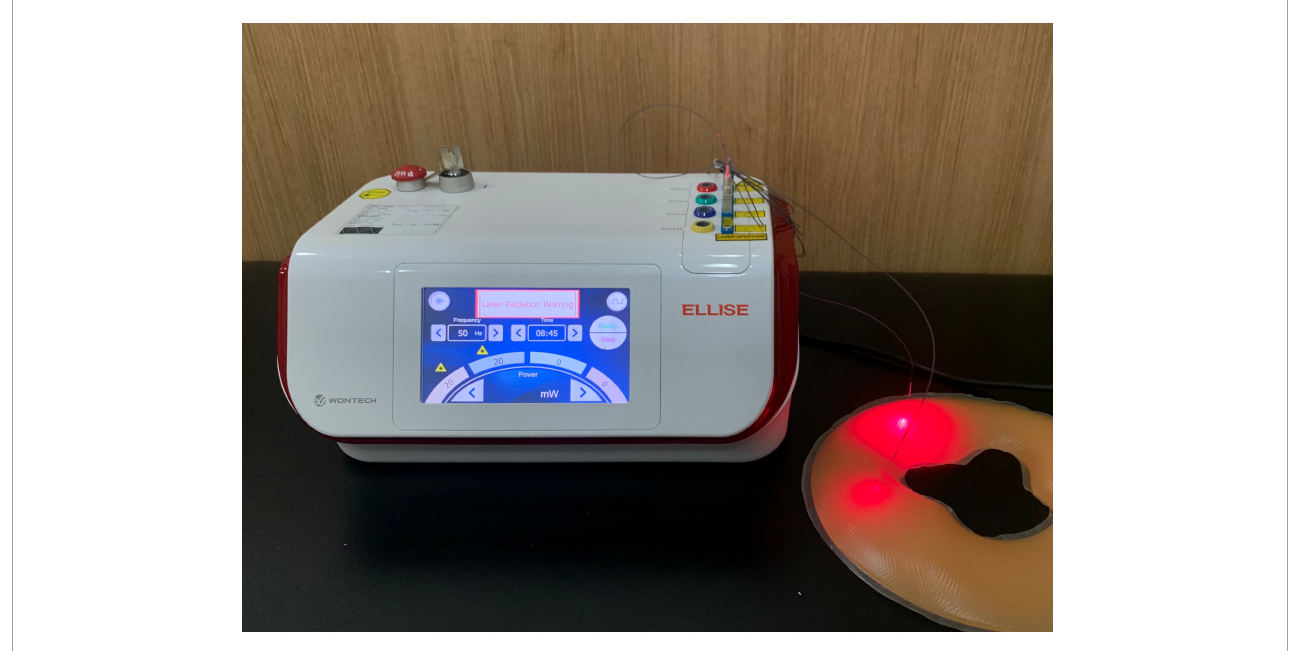
FIGURE1 Invasive laser acupuncture (ILA)